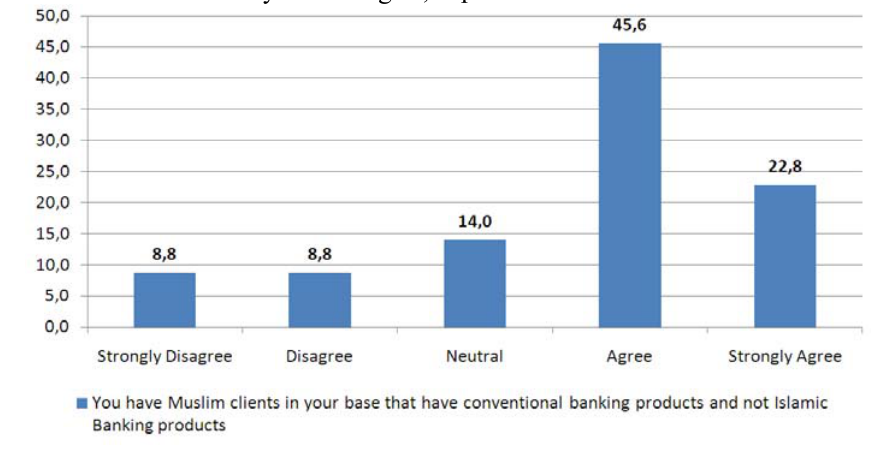
Fig. 7. Do you have Muslim clients in your base that have conventional banking products and not Islamic banking